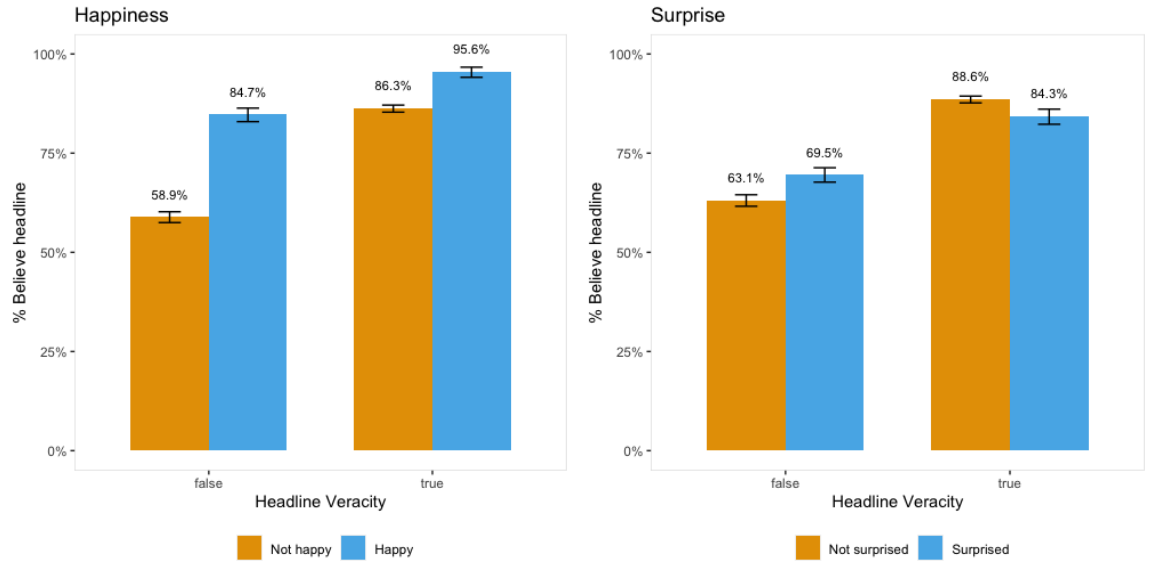
Figure 2. Rate of belief in true/false headlines for happiness and surprise. Blue bars indicate headlines where respondents reported feeling that particular emotion. Orange bars indicate headlines where respondents reported not feeling that particular emotion. Error bars represent 95% confidence